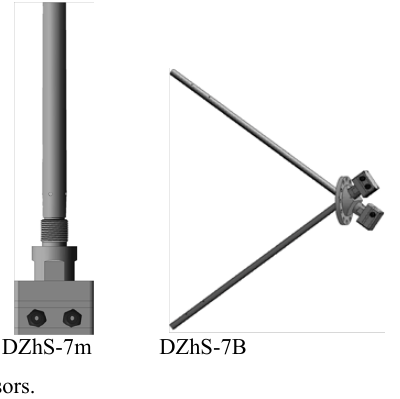
Fig. 2. Sensors. Fig. 3. System unit SB-5.